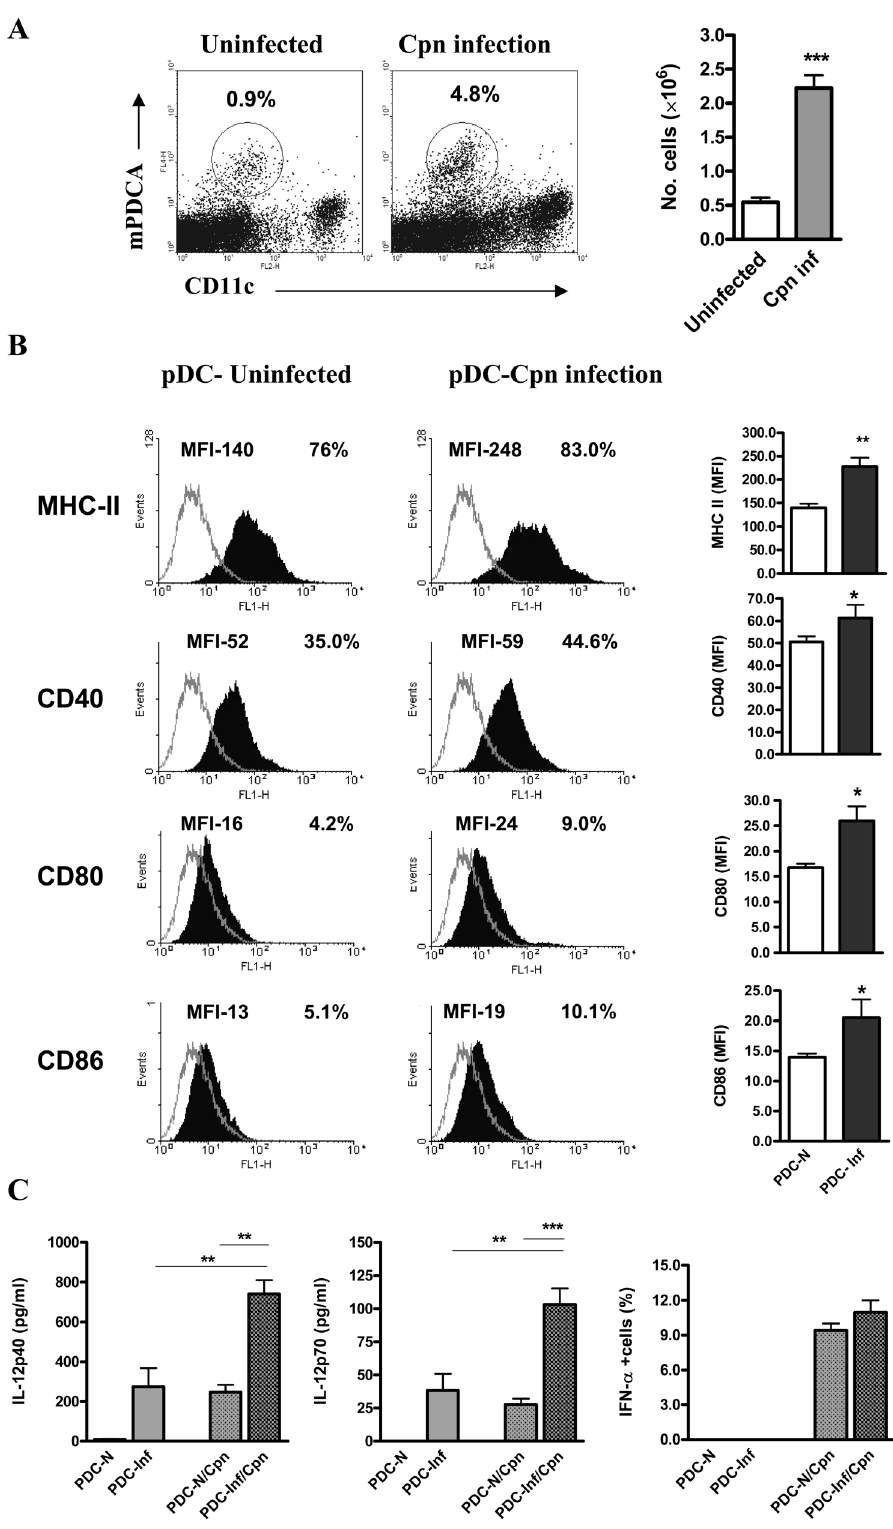
Figure 1. Activation of pDCs following Cpn infection. C57BL/6 mice were intranasally infected with Cpn (3 6 10 6 IFUs). Mice were killed at day 9 p.i., and lungs were aseptically collected. To analyse pDCs, lung cells were stained and analysed by flowcytometery as decribed in the Materials and Methods . pDCs were identified as mPDCA + CD11c int/lo cells. A, pDC expansion after Cpn infection. Shown are representative dot plots with the percentages of pDCs in Cpn infected mice in comparison with uninfected mice (left) and the graphical summary for the absolute numbers of pDCs in the lungs. Total pDC number per mouse lung was calculated as % mPDCA + CD11c int/lo cells x total number of cells per mouse lung/100. B, Expression of MHC II and costimulatory molecules CD40, CD80 and CD86 on gated pDCs (filled histograms) and isotype control (dotted line) are